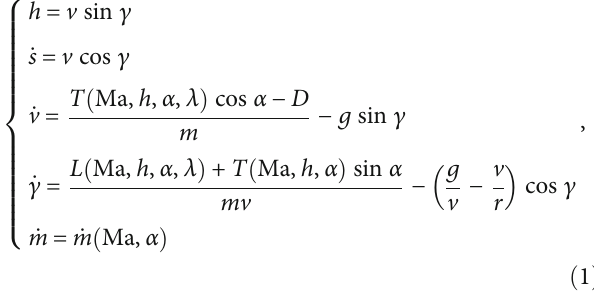
ffiffiffiffiffiffiffiffiffiffiffiffi